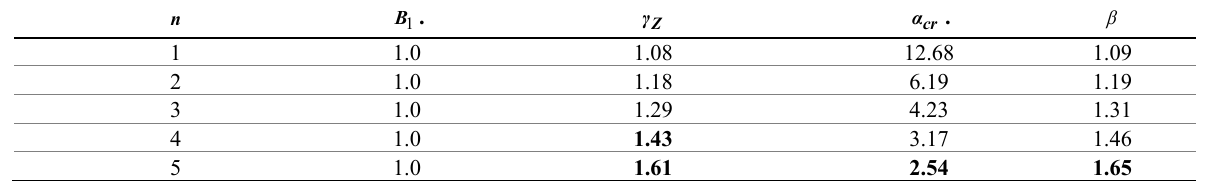
Table 4 – Multiplier coefficients Z γ , cr α and β . (bold font values exceed the applicability limit of the methods) Source: Authors (2020). n 1 B . Z γ cr α .